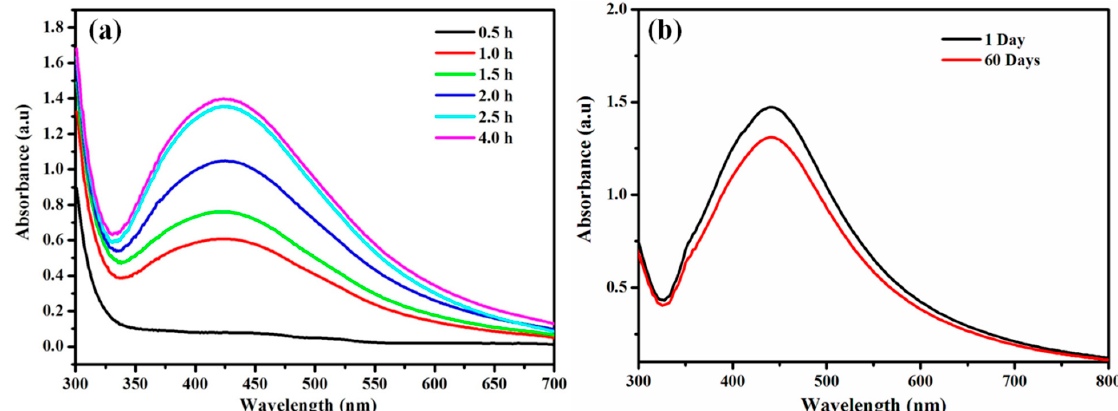
Figure 2. ( a ) UV-visible absorbance spectra kinetic reaction of the green synthesized AgNPs during the preparations at different time intervals. ( b ) UV-Vis spectra showing the stability of green synthesized AgNPs after 1 day and 60 days of preparation.